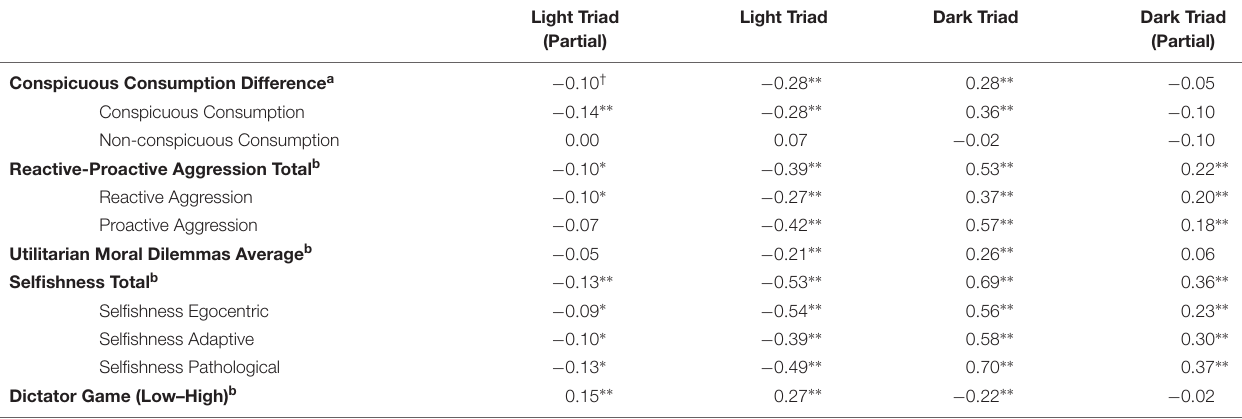
Light Triad Light Triad Dark Triad Dark Triad (Partial)